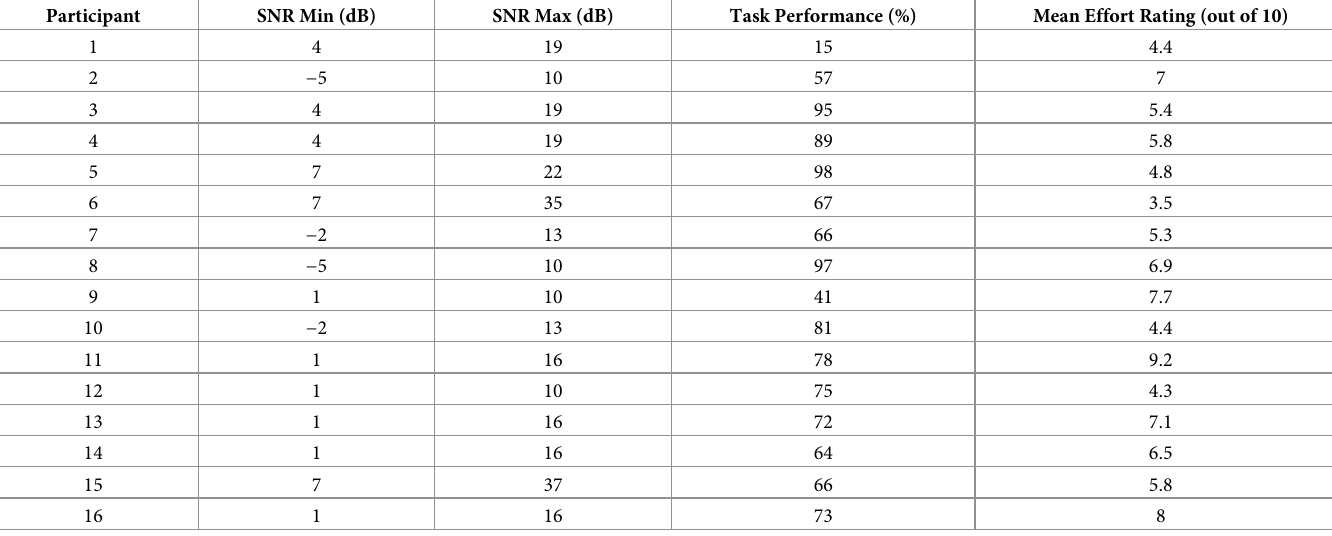
Table 2. Digits-in-noise task parameters and average performance for each participant.